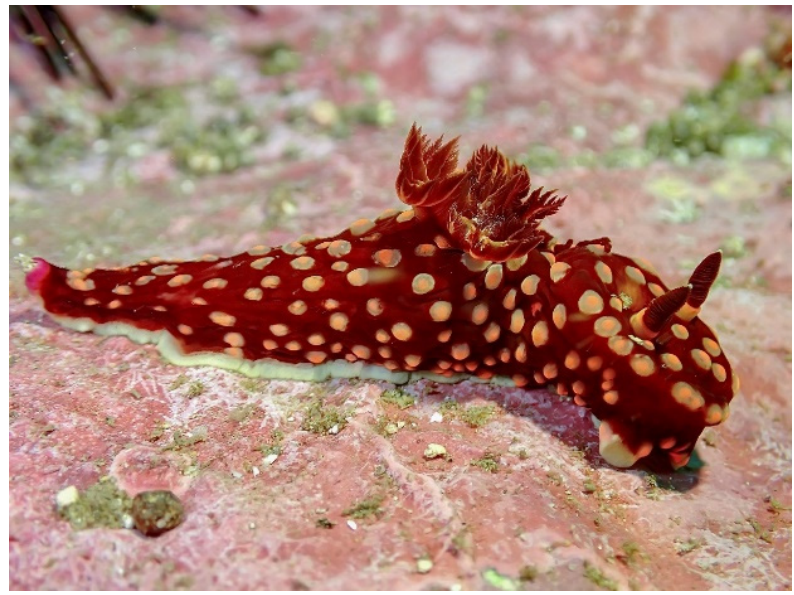
Figure 8. Nembrotha yonowae , South Solitary Island, NSW, 15 February 2022. Photo: N. Fripp.